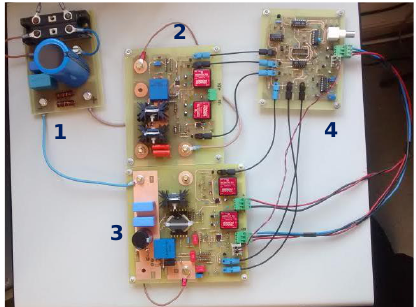
Figure 12. Simulated waveforms for the FB+buckpower supply.